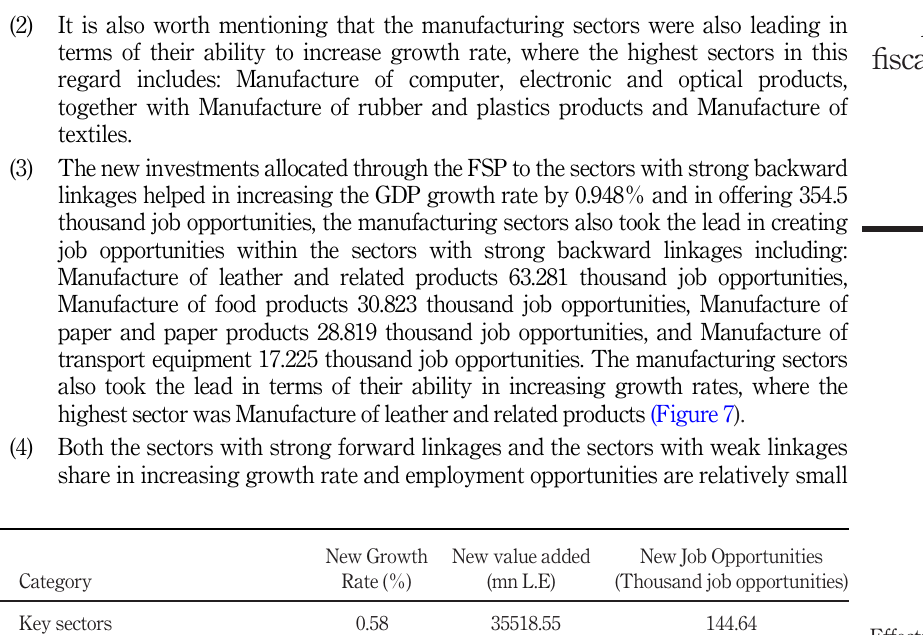
Table 1. Effects of the FSP on